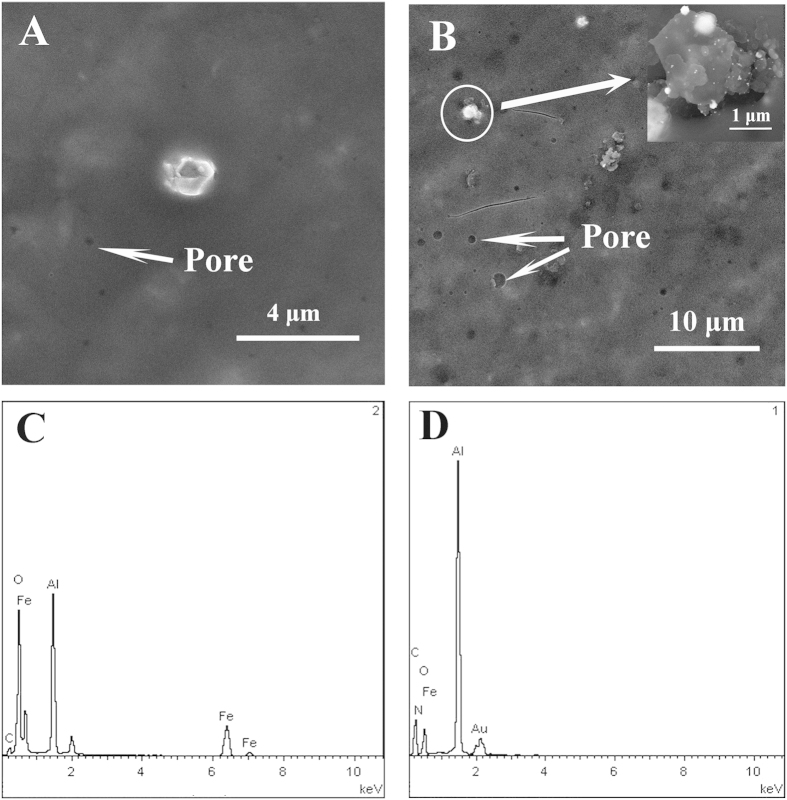
The SEM image of the PDA/Fe3O4@C@PGC nanocomposites (A) and the Au/PDA/Fe3O4@C@PGC nanocomposites (B); The EDX spectrum of PDA/Fe3O4@C@PGC nanocomposites (C) and Au/PDA/Fe3O4@C@PGC nanocomposites (D).